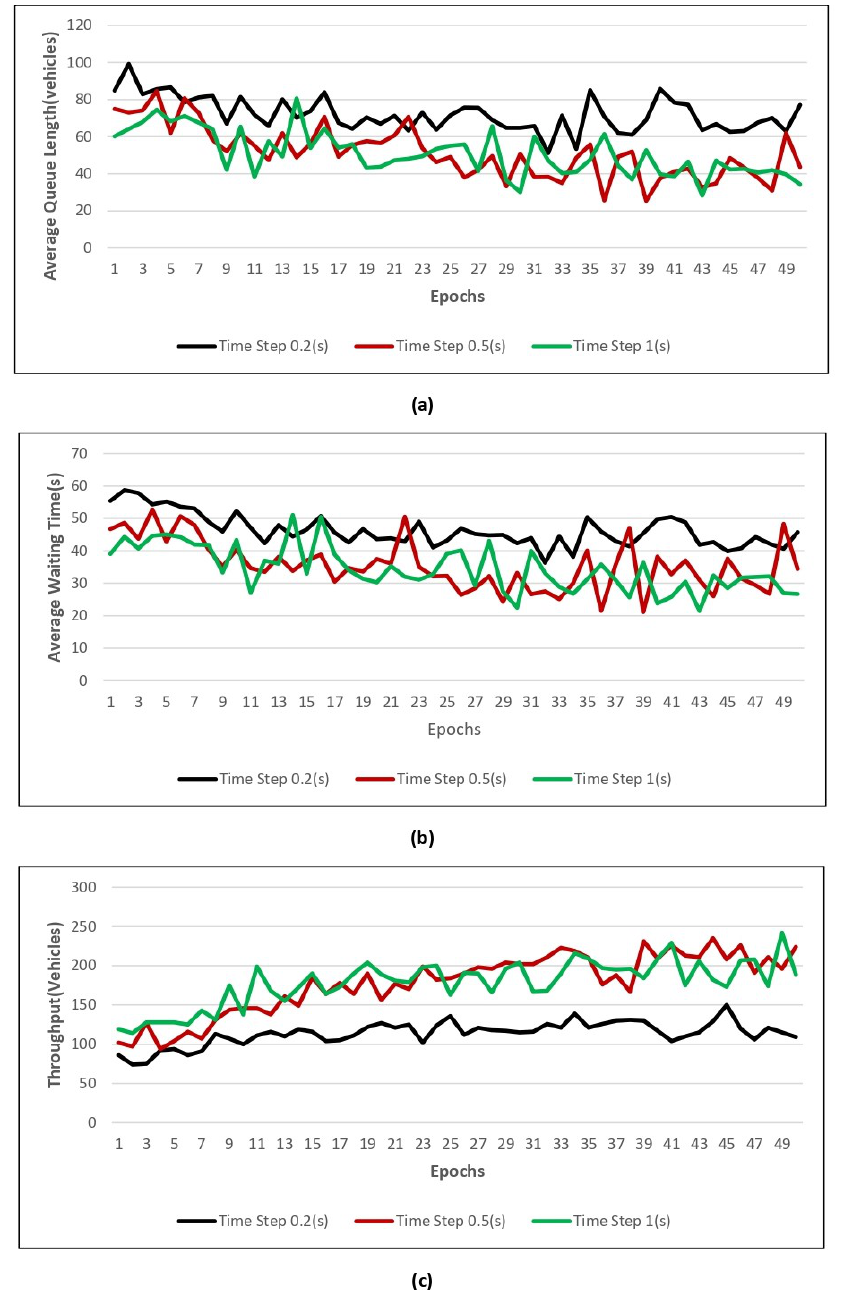
Figure 12. Performance results while training with three action time steps and using 50